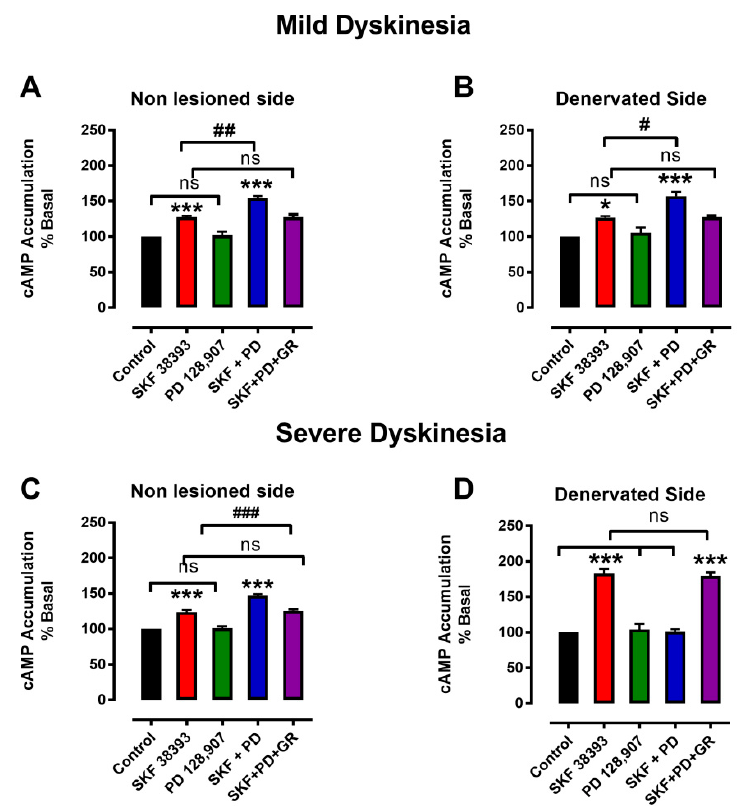
Figure 3. Changes in cAMP accumulation in the SNr of animals that developed either mild or severe dyskinesia during L-DOPA treatment. ( A , B ) Synaptosomes obtained from animals in which L-DOPA treatment produced mild dyskinesia. ( C , D ) Synaptosomes obtained from animals in which L-DOPA treatment produced severe dyskinesia. Note: *** p < 0.001, comparison with the control; # p < 0.05, ## p < 0.01, and ### p < 0.001, comparison with SKF38393; ns = not significant between groups. Values mean ± standard error, n = 3 experiments, four replications per experiment.